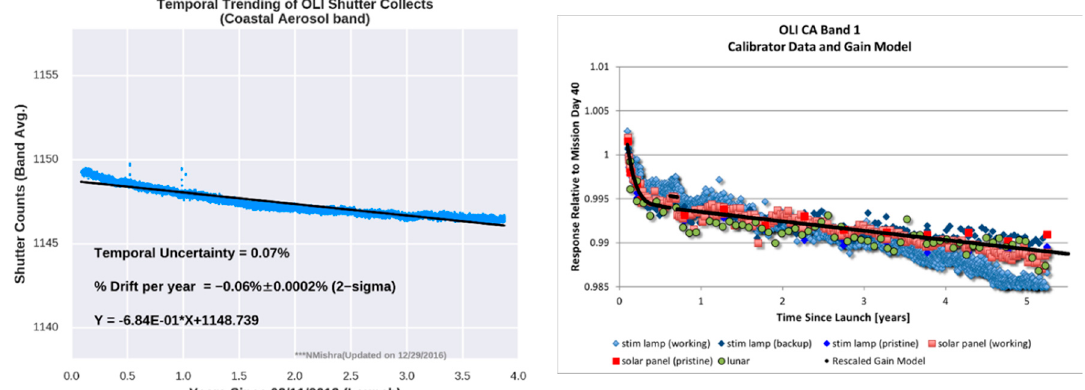
Figure 3. Radiometric bias and gain trends for Landsat 8 Operational Land Imager Coastal Aerosol Band over approximately 5 years of operation.